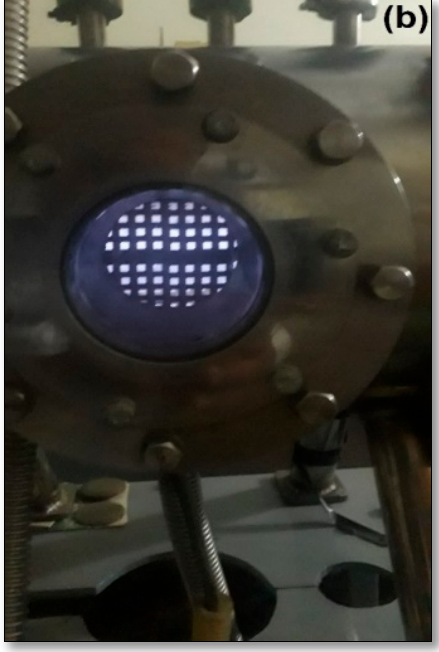
Figure 2. ( a ) The chamber’s schematic. ( b ) Typical view of discharge.